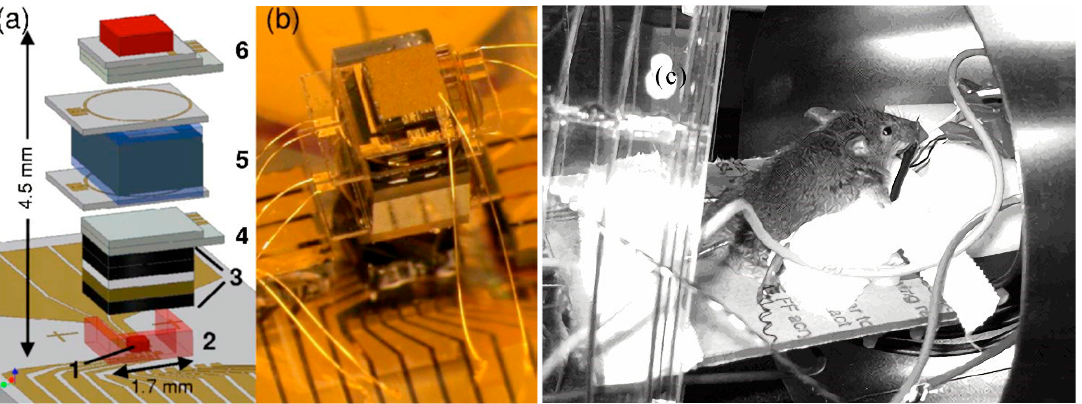
Figure 18. NIST micro-fabricated magnetometer scheme for measuring mouse heart magnetism (2007). ( a ) & ( b ) Magnetometer Structure, ( c ) Magnetometer applied to mouse magnetic measurement. Reprinted from Ref [101].